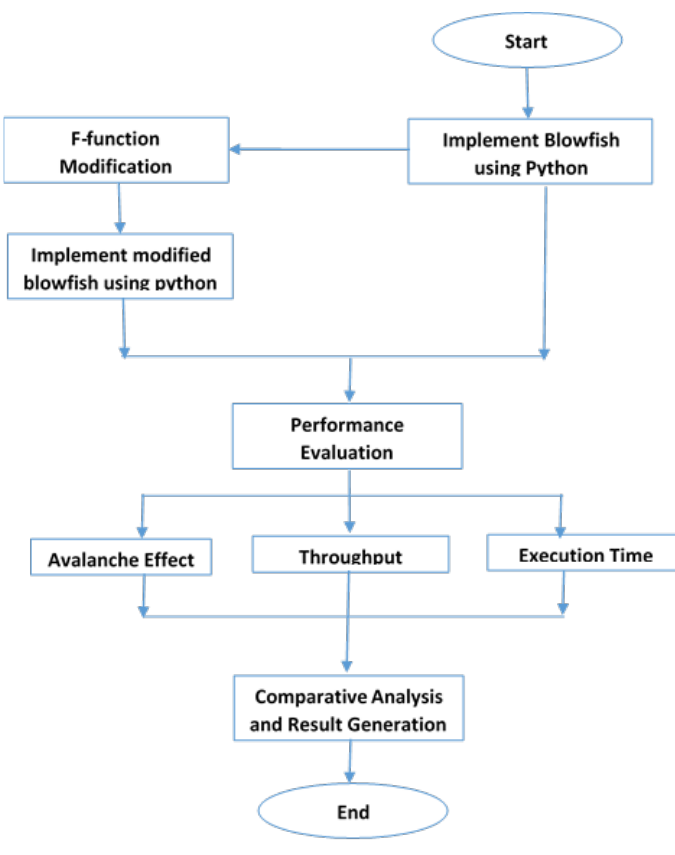
Figure 1. Methodology workflow diagram of the proposed modified algorithm.